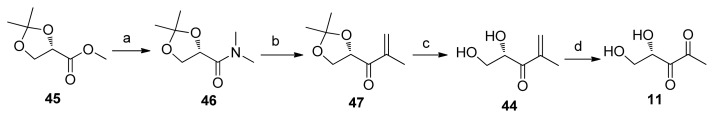
Vanderleyden’s synthesis of DPD. Reagents and conditions: (a) NH(CH3)2, EtOH; (b) CH2=CCH3MgBr, Et2O/THF; (c) Dowex resin, MeOH; (d) O3, MeOH, DMS.